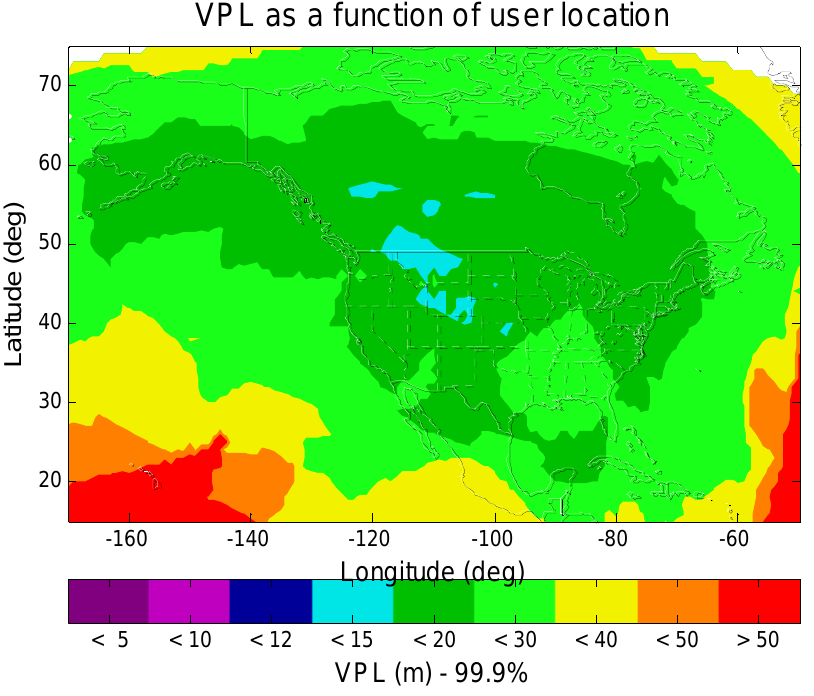
Figure 8. The 99.9% VPL contour of the dual-frequency GPS/WAAS user with an improved signal model. The VPL values could not meet the CAT I